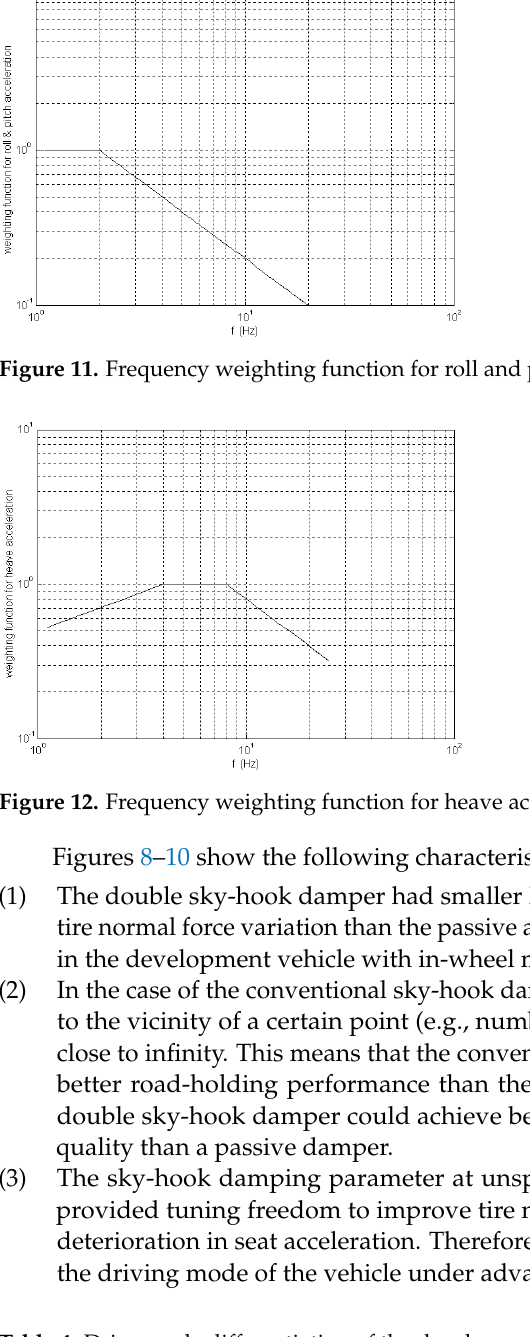
Figure 10. Tire normal force variation vs. roll acceleration.